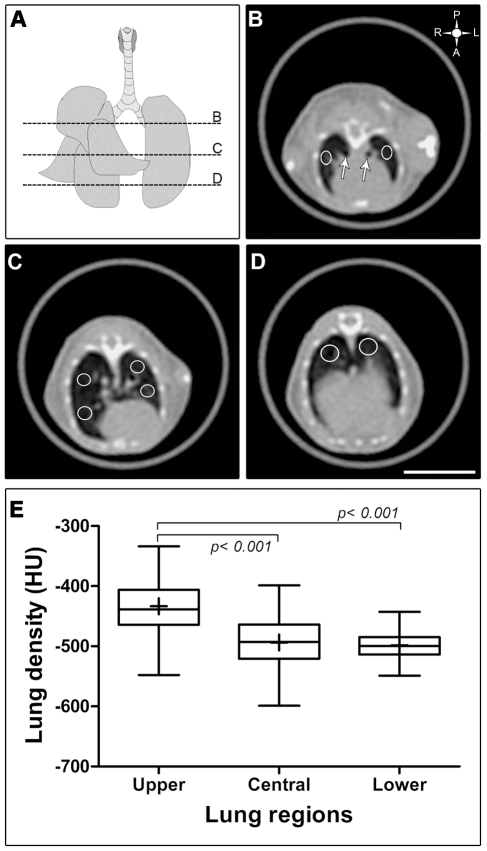
Quantification of lungs density in healthy BALB/c mice.(A) Mouse pulmonary figure in coronal view from a healthy BALB/c mice showing four right lobes and a unique left lobe. Dotted lines correspond to the places where selected tomographic slices were taken: upper or hilar (B), central or middle (C) and lower or lung bases (D) The upper left symbol in figure B, gives the spatial position of posterior or dorsal (P), anterior or ventral (A), left (L) and right (R) regions. (E) Box plot showing the upper, central and lower pulmonary density in healthy BALB/c mice. Density was expressed by Hounsfield units (HU) scale and was measured in ten animals at 7, 11, 15, 19 and 23 weeks of age. One-way ANOVA was used to compare the groups. Upper lung density showed a statistically significant difference in relation to central and lower lung zones, p≤0.001. ns  =  non significant.